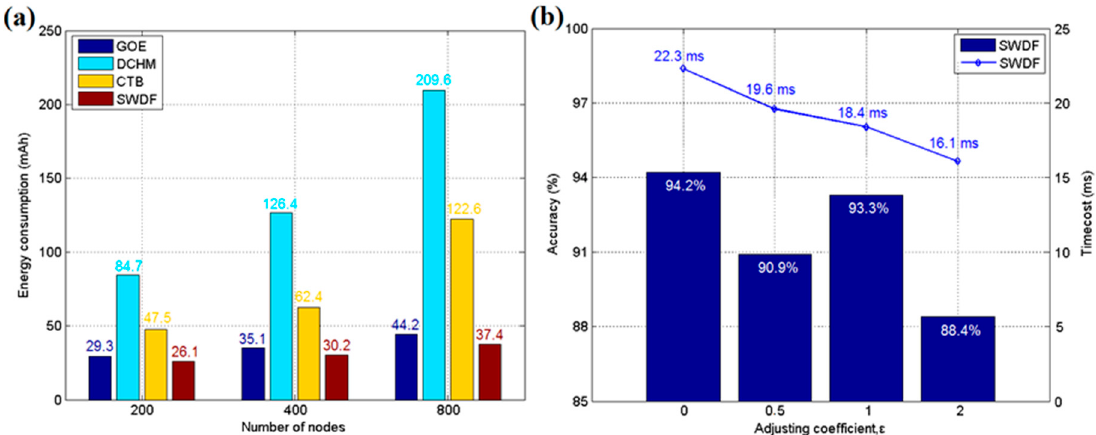
Figure 6. ( a ) The average energy consumption of each sensor node over an hour; ( b ) The average accuracy and time/cost for various adjustment coefficients ε .